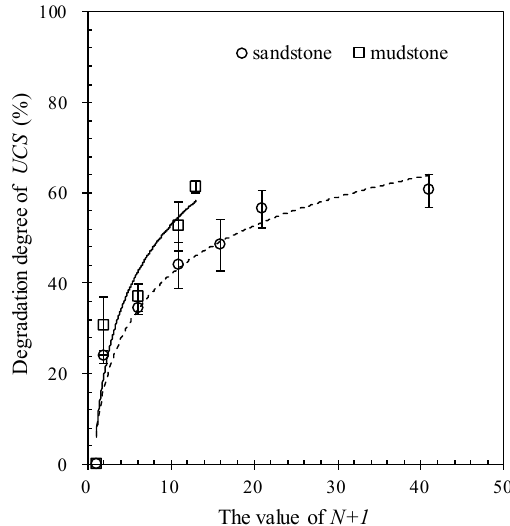
Figure 10. Relationship between the degradation degree of the UCS and the value of N + 1.